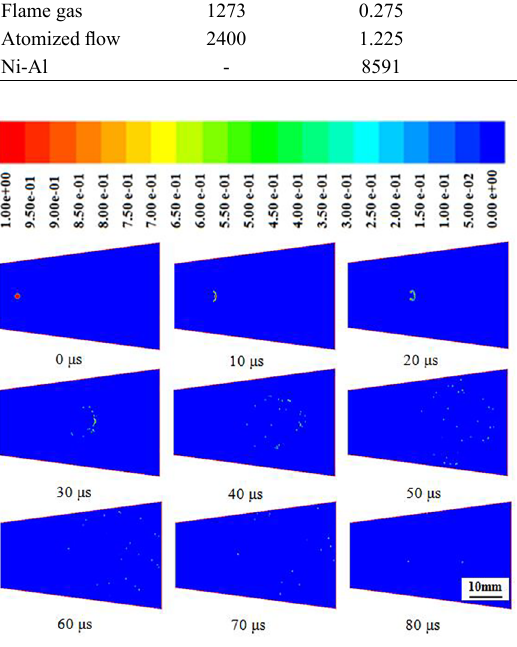
Table 2. Thermo-physical property indexes of flame gas and particles. Material